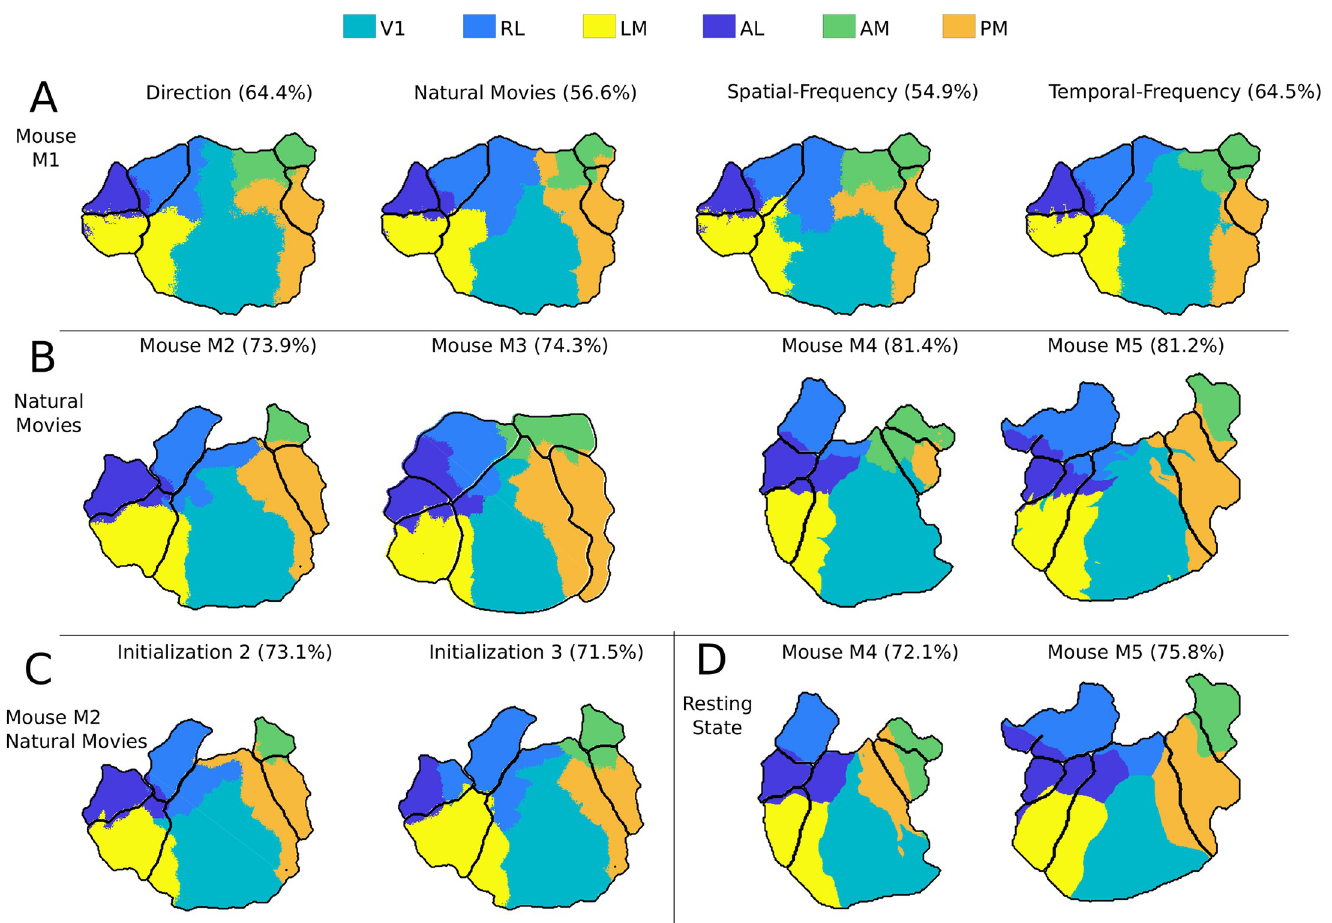
Fig 6. Boundaries obtained by clustering visual cortex areas using the semi-supervised pipeline. A ) Boundaries derived using different visual stimuli in one mouse. Visual stimuli and accuracy (in %) are noted. B ) Boundaries obtained for different mice using natural movies as stimuli. C ) Boundaries obtained for different initializations of UBM for the same mouse and keeping visual stimuli unchanged. D ) Boundaries derived from resting state responses.